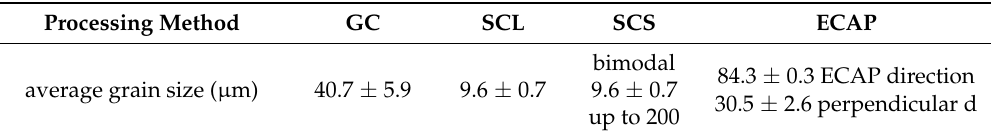
Table 2. Chemical composition of the alloy processed by various methods.